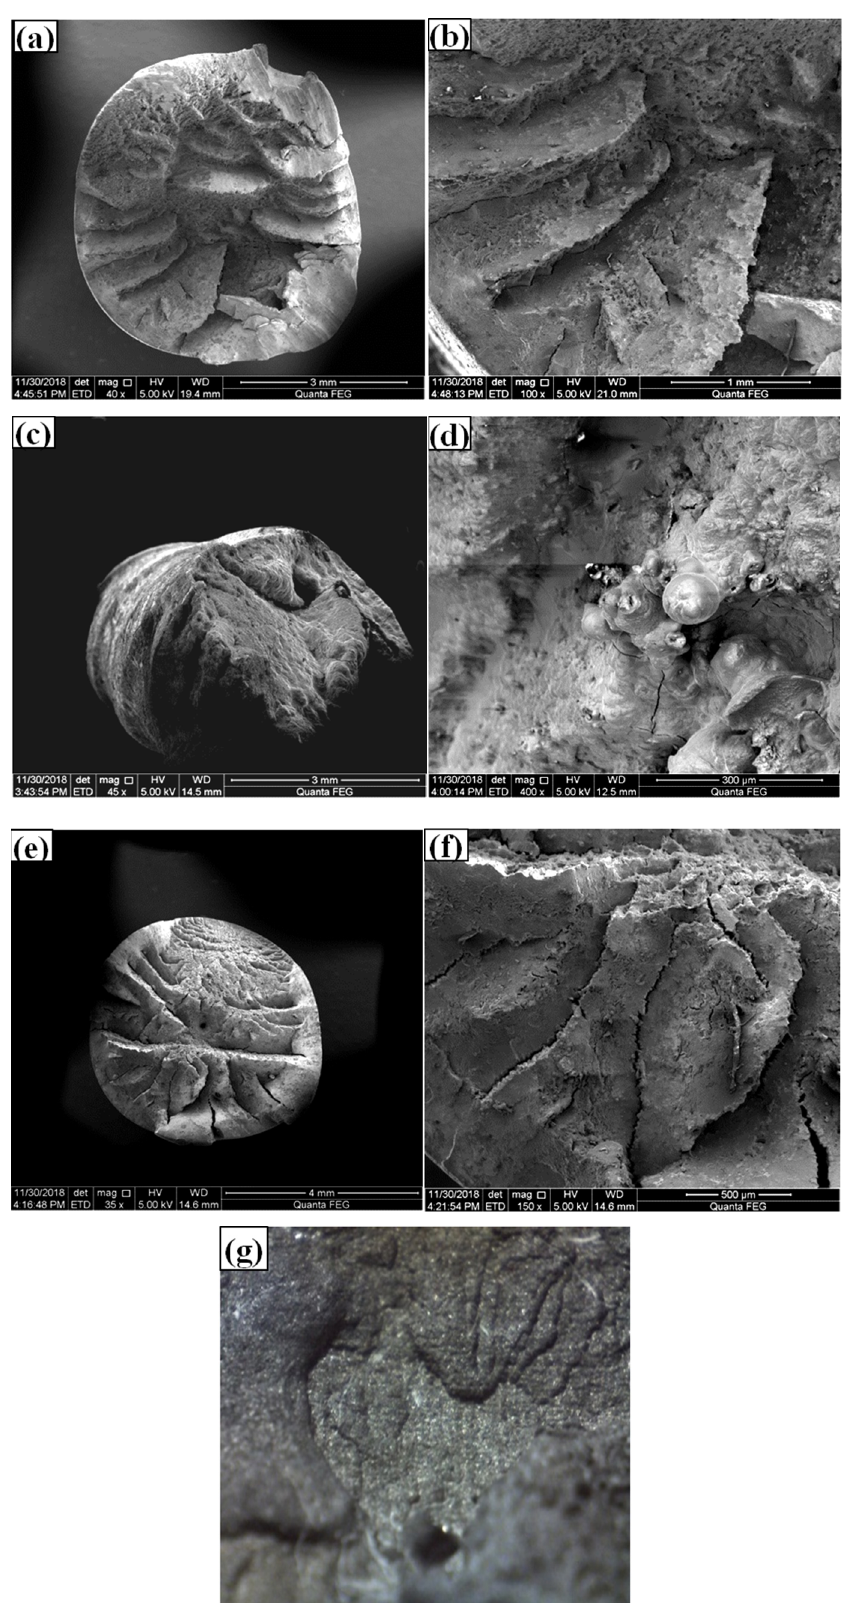
Figure 7. SEM images of rupture surface of wires: ( a , b ) wire A, ( c , d ) wire B, ( e , f ) wire C, ( g ) corrosion Figure7. SEMimagesofrupturesurfaceofwires: ( a , b )wireA,( c , d )wireB,( e , f )wireC,( g pits.